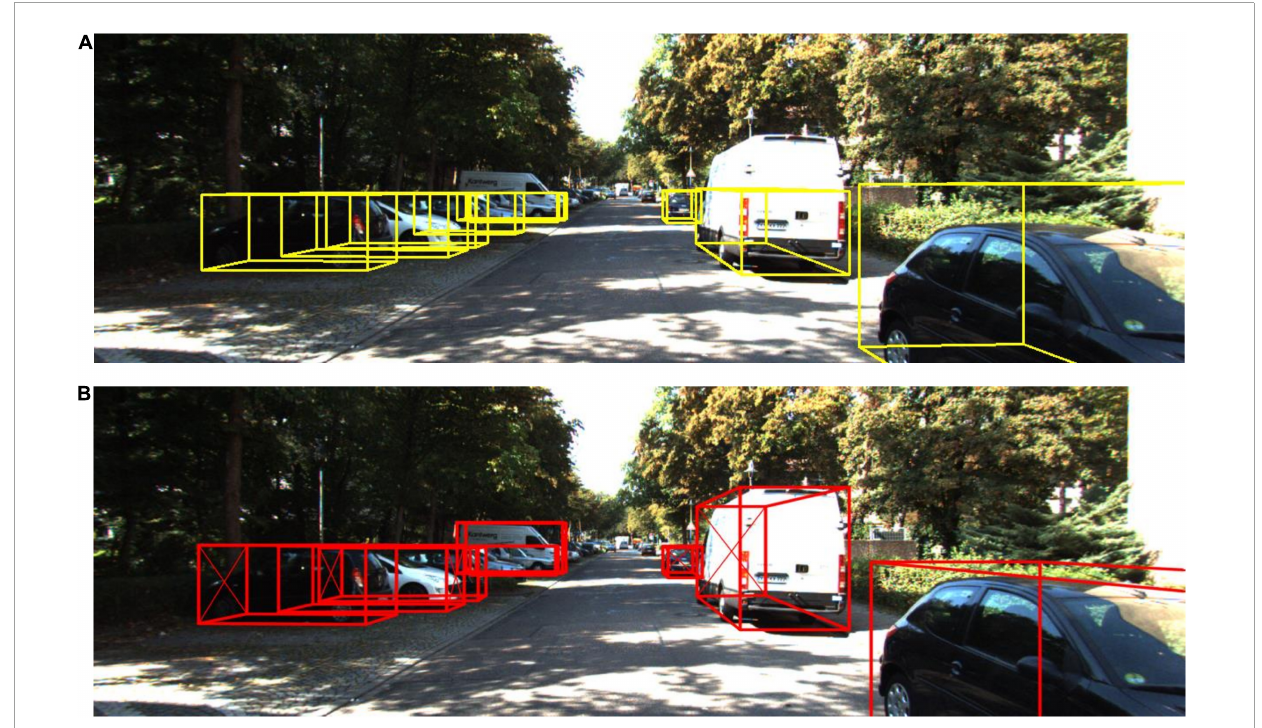
FIGURE9 Comparison of our method with the detection results of Complex-YOLO. (A) 3D detection results of Complex-YOLO. (B) 3D detection results of our